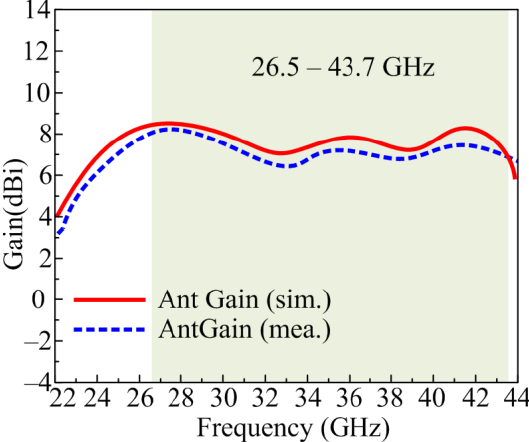
Figure 6. Comparison among simulated and experimental gain results.